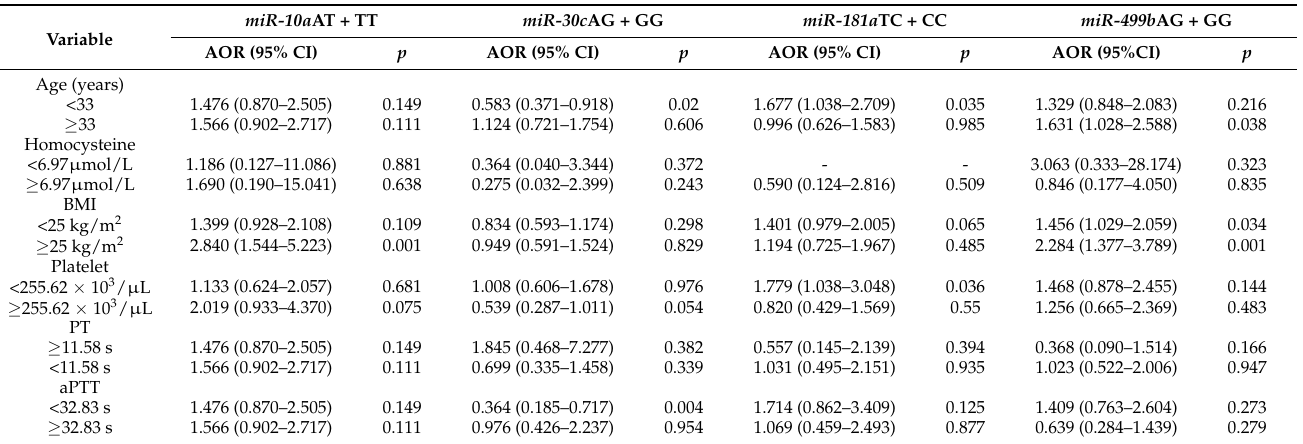
Table 3. Adjusted odds ratios for risk of recurrent pregnancy loss associated with miRNA polymor- phisms combined with clinical